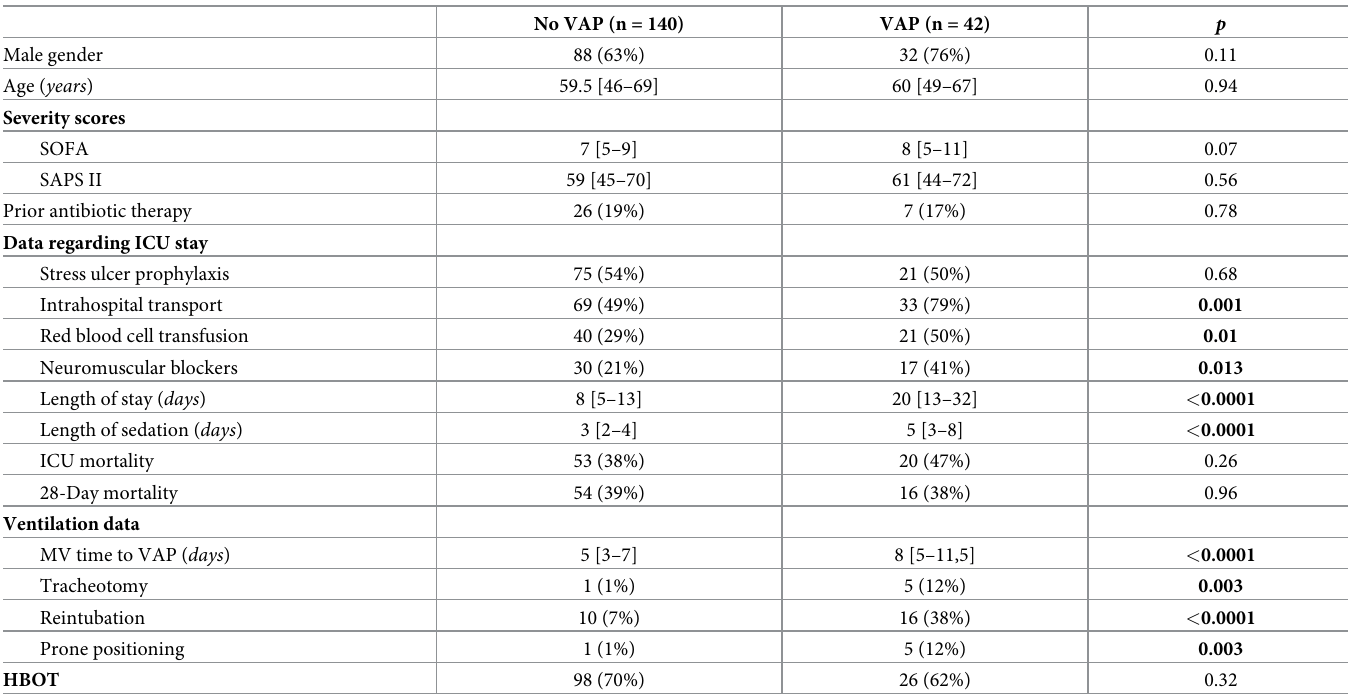
Table 2. Data on patients with / without